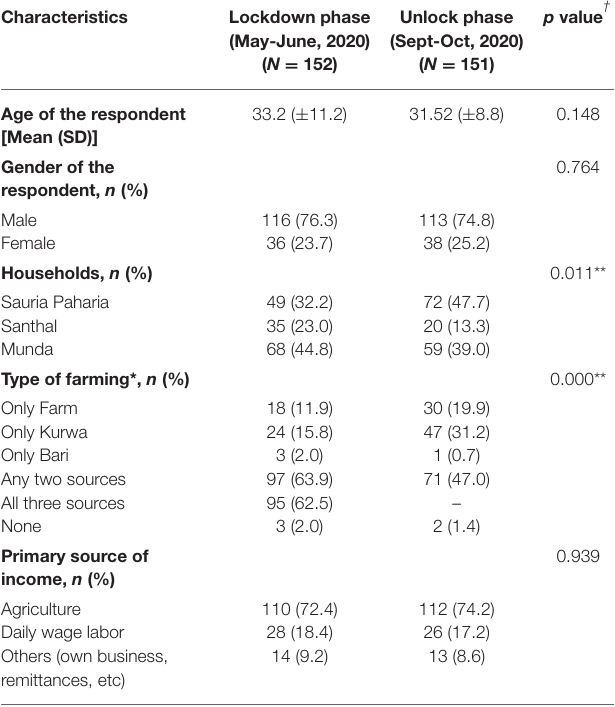
TABLE 1 | General profile of telephonically surveyed households belonging to indigenous communities of Jharkhand, India.